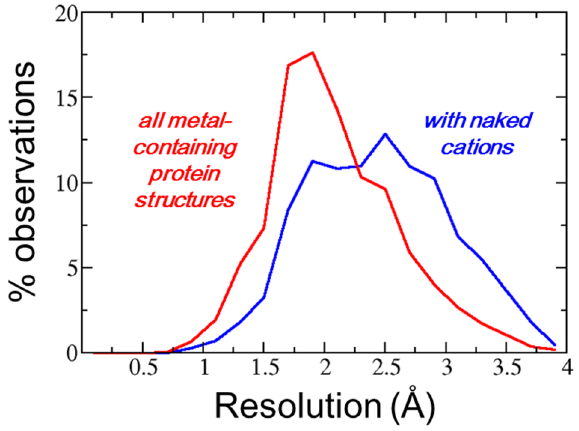
Figure 1. Distribution of the resolution values for the entire set of metal-containing protein crystal structures (red line) and for the protein crystal structures that contain naked metals (blue line).